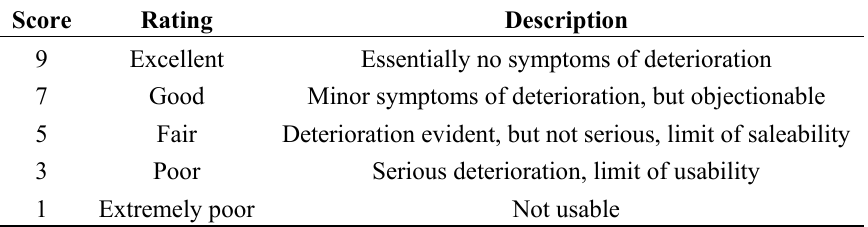
Table 3. Rating scale for overall visual quality of produce.